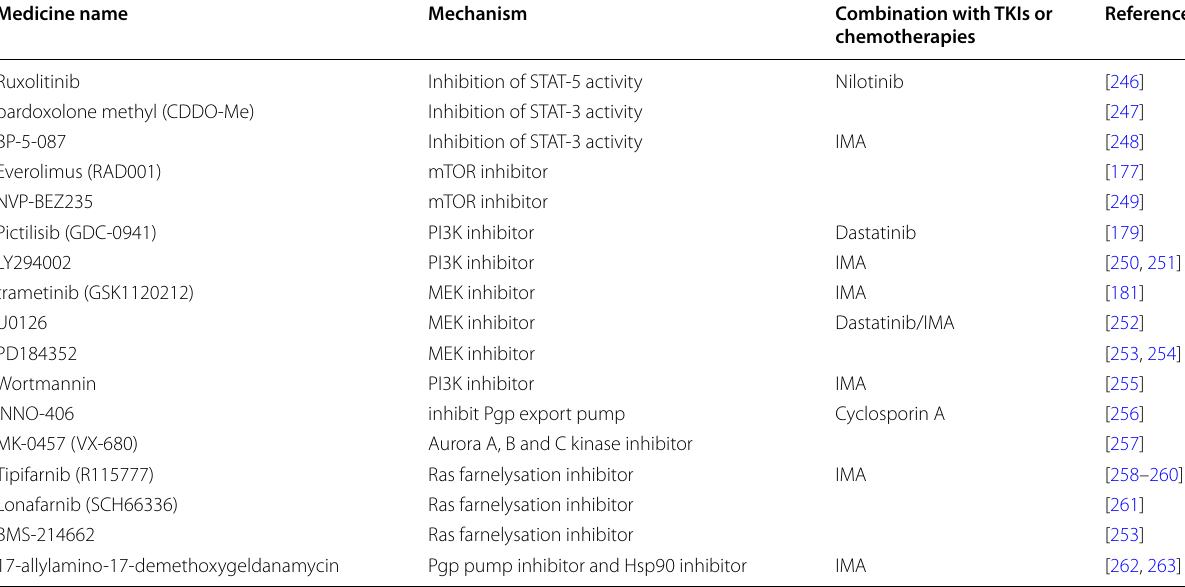
STAT, signal transducer and activator of transcription; mTOR, mammalian target of rapamycin; PI3K, phosphoinositide 3-kinase; MEK, mitogen-activated protein kinase kinase; Pgp, P-glycoprotein; Ras, rat sarcoma virus; Hsp90, heat shock protein 90